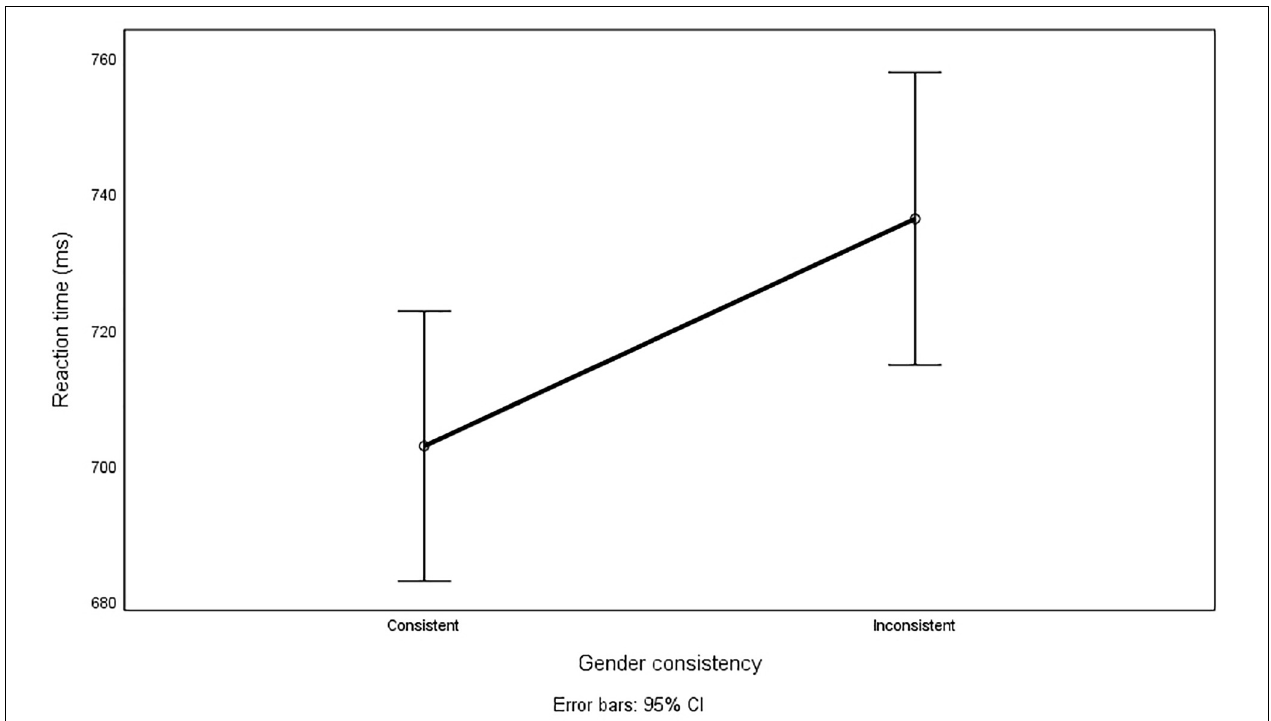
FIGURE 2 | Reaction times to gender-consistent and gender-inconsistent